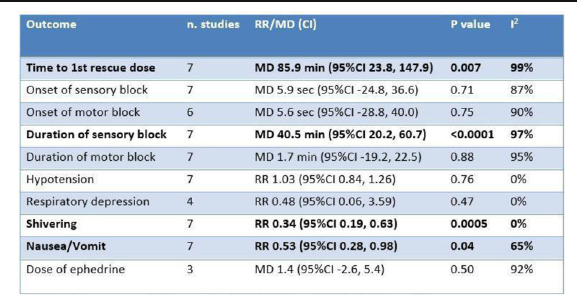
Table 1 (abstract A161). Summary of the results. RR : Relatice risk; MD: Mean